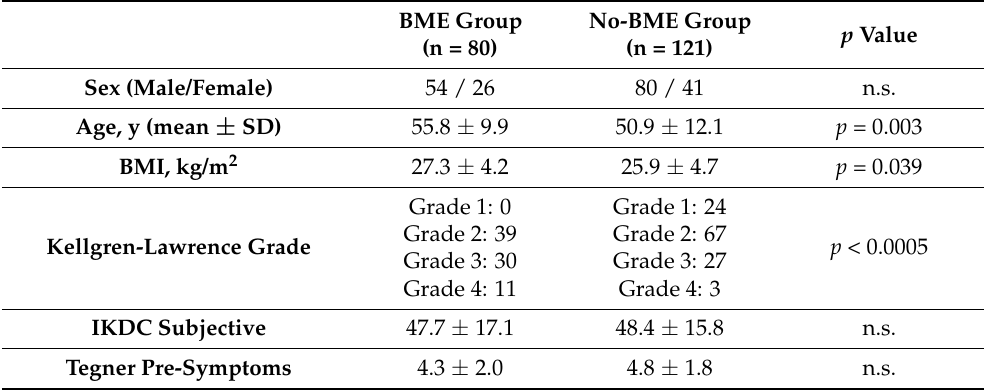
Table 1. Baseline demographic characteristics and clinical scores of patients of both